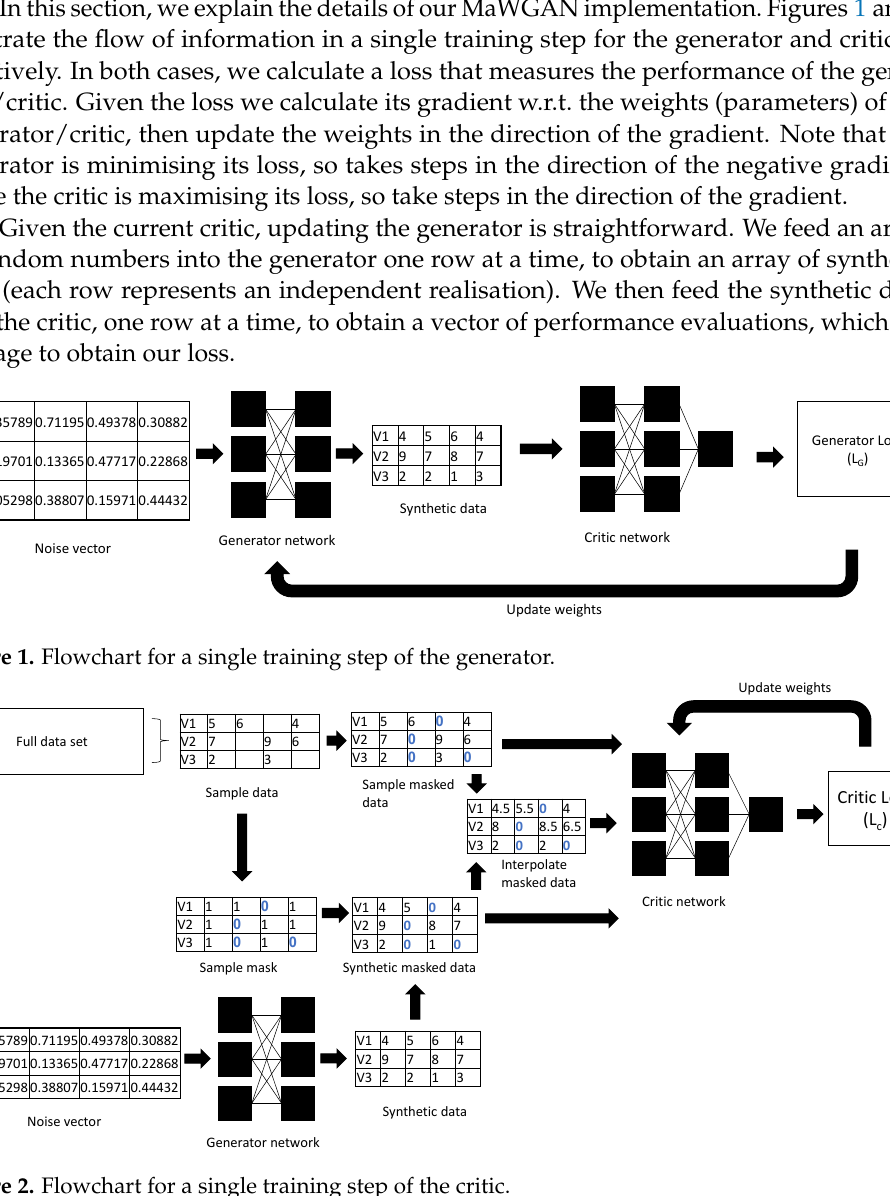
Figure 2. Flowchart for a single training step of the